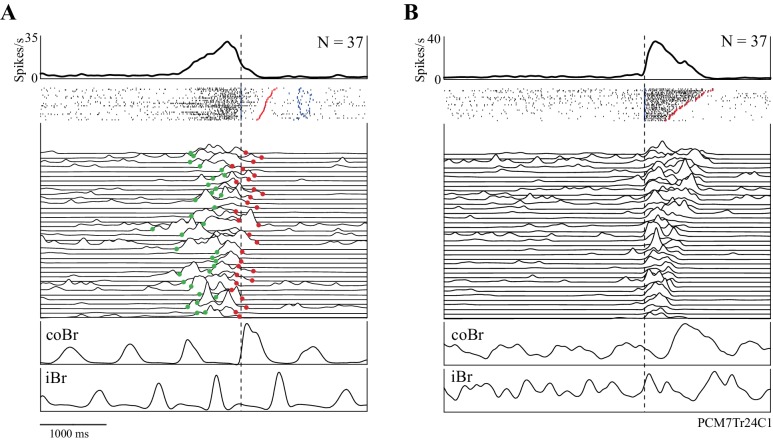
Detection of bursts of unit activity in individual trials.From top to bottom: averaged peri-event histogram (PEH) of cell activity; individual trials in the form of rasters and instantaneous frequency; averaged activity of the coBr and iBr. Data trials include those from the matched, visual dissociation and acceleration tasks, explaining the difference in onset and duration of bursts. (A) Cell activity is aligned to the onset of the activity in the coBr (indicated by the vertical line). (B) Activity is aligned to the detected onset of the burst of unit activity in each trial (indicated by the vertical line). In A, data are rank-ordered according to the duration of the burst of the period of activity in the coBr. In B, they are rank-ordered according to the duration of the measured unit activity. Staggered red, vertical lines on the rasters in A, B indicate the end of the period of activity in the coBr and of the cell activity, respectively. Green and red circles in A indicate, respectively, the onset and offset of the burst of activity. Cell activity in the PEH and the individual trials is filtered at 25 Hz. Note that synchronization on the onset of the cell discharge results in substantial smearing of the EMG bursts supporting the data illustrated in Figure 3 showing that the onset of cell discharge is not time-locked to the onset of EMG activity.